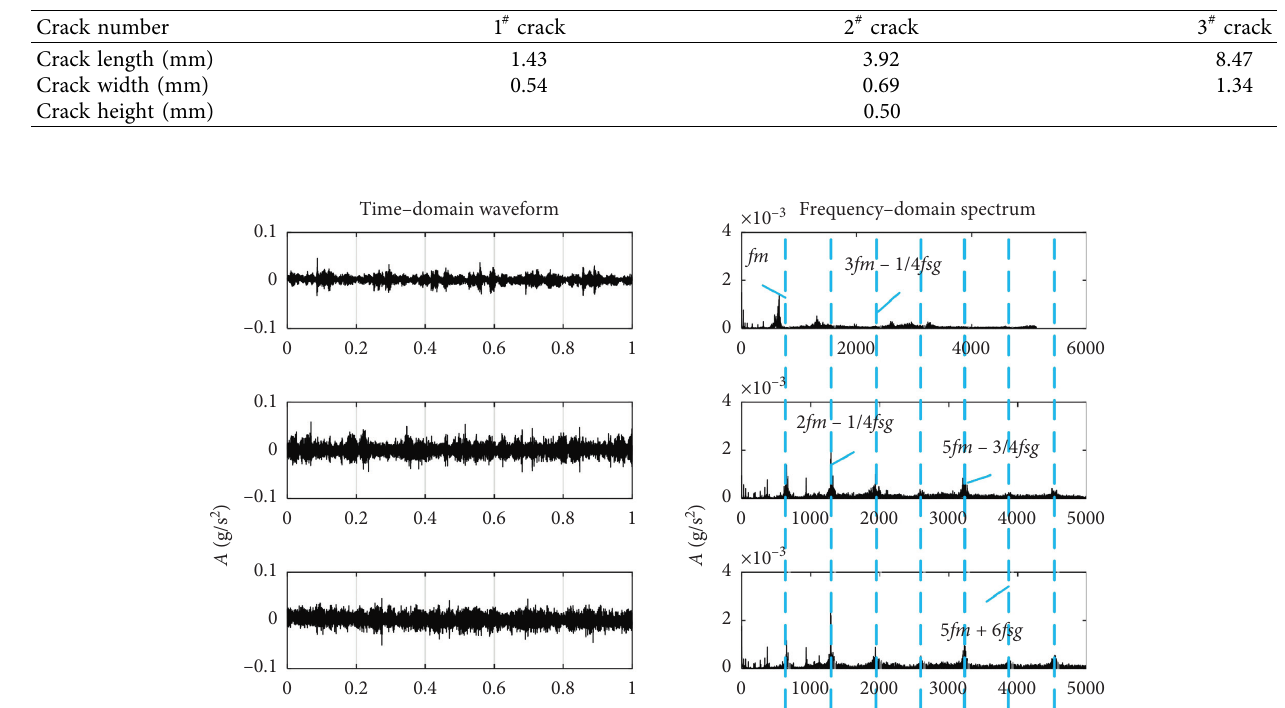
Table 7: Actual crack parameters of tested gear.